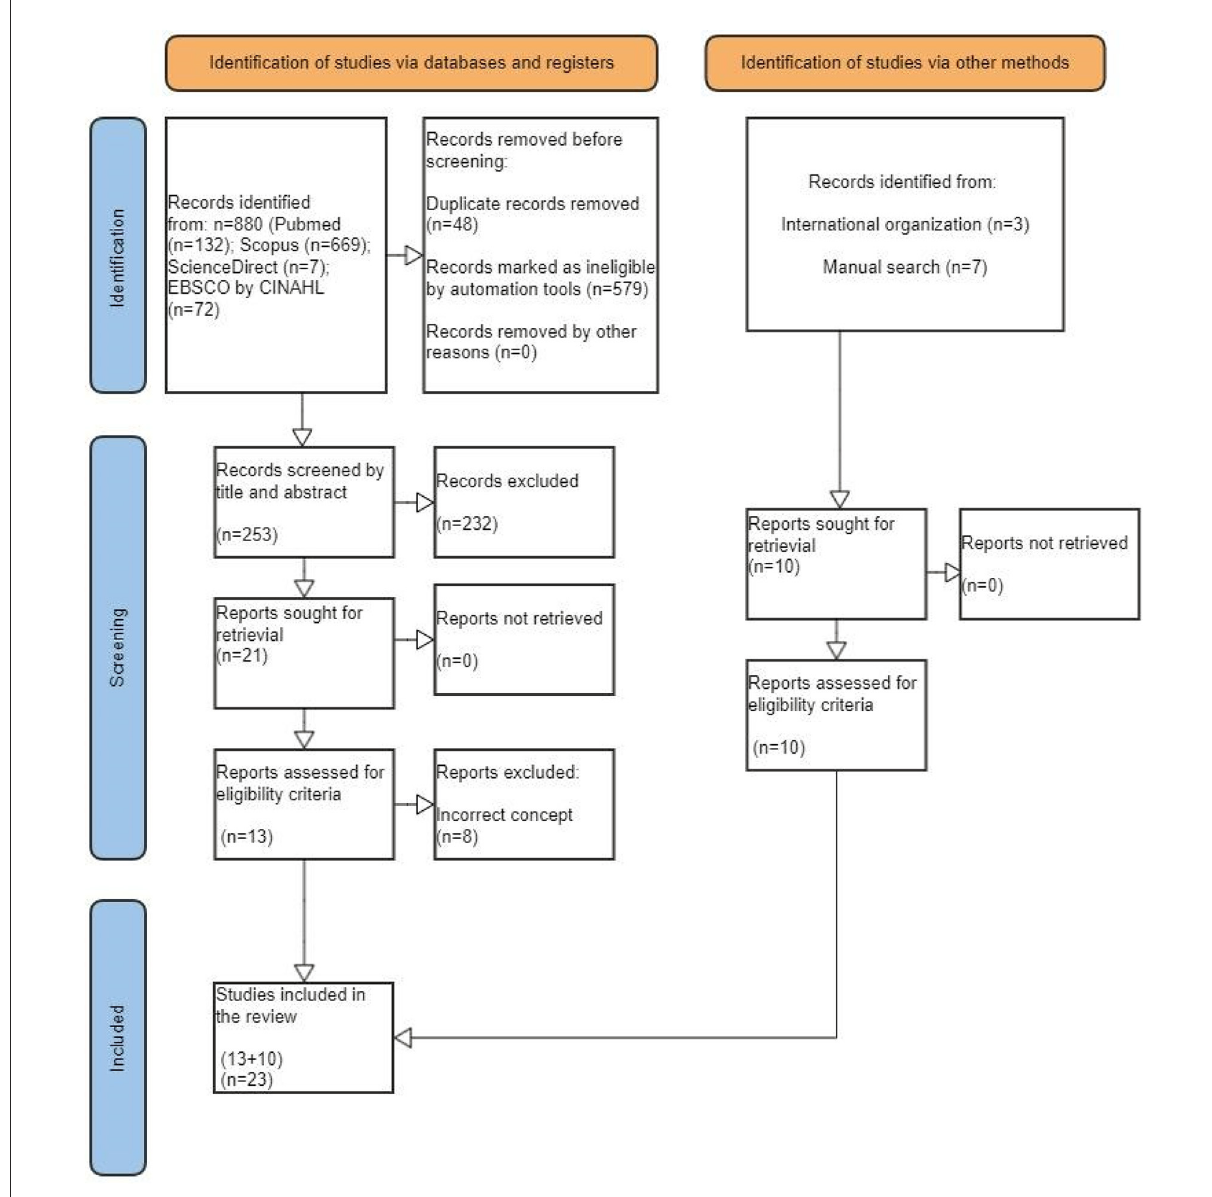
FIGURE3 PRISMA ScR flow diagram: Scope review process for syphilis